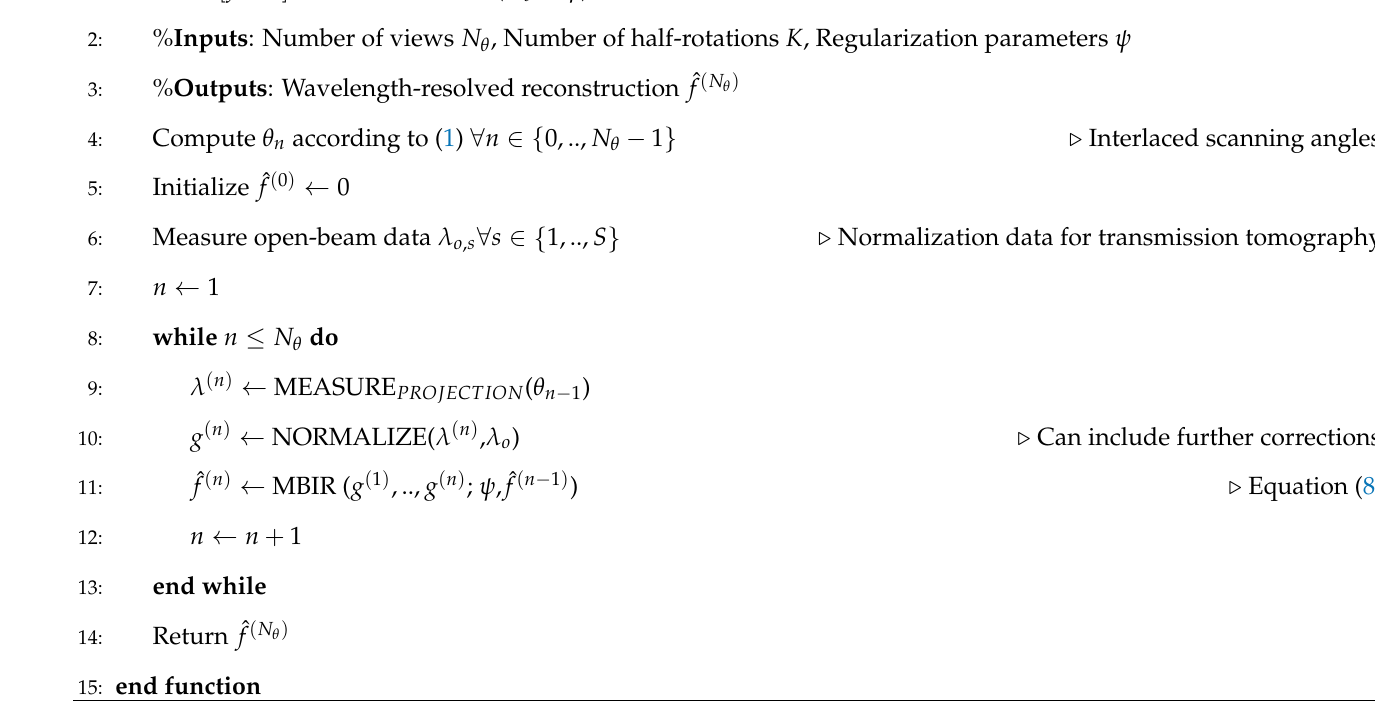
Algorithm 1 The proposed framework for wavelength-resolved neutron tomography systems. Prior to the scan we decide a fixed number of views to measure N θ and the number of half-rotations over which this will occur K . After each measurement the object can be reconstructed using the MBIR algorithm. The reconstruction from the previous stage is used as a initial condition for the next stage in order to accelerate the convergence i.e., time to reconstruct for the MBIR